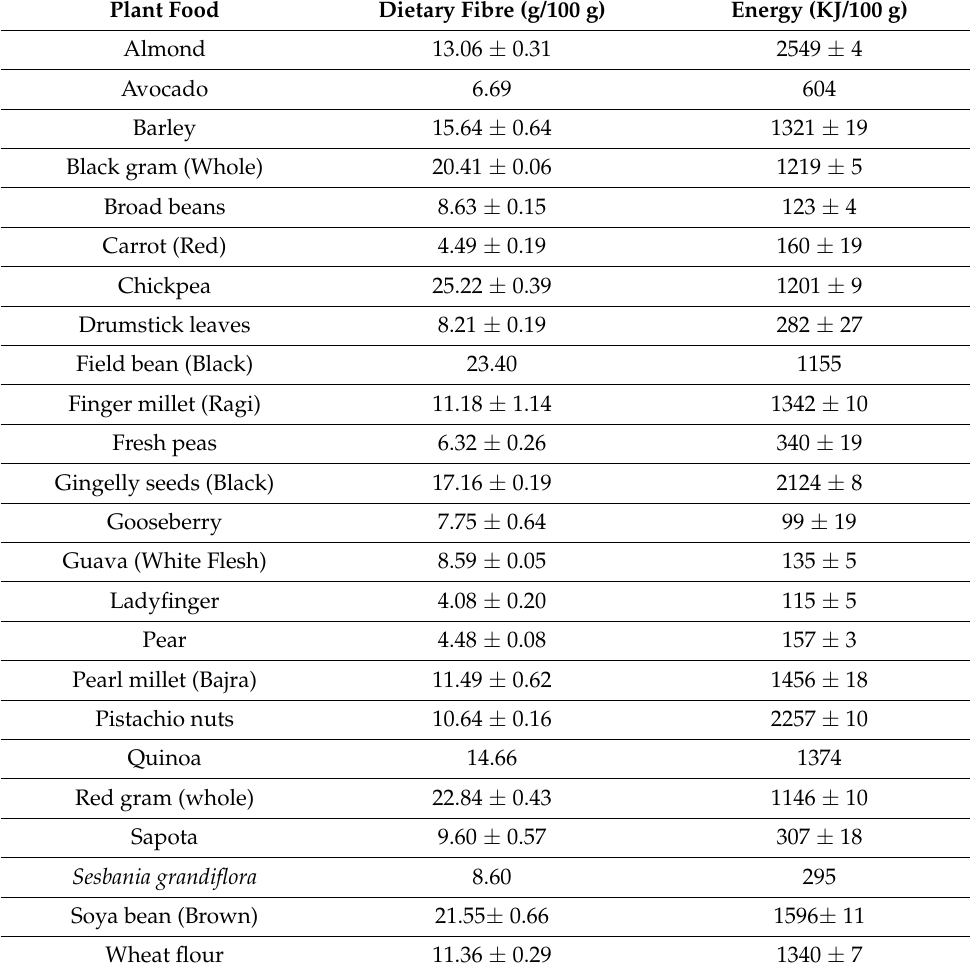
Table 1. Dietary fibre and energy content of some selected fibre-rich